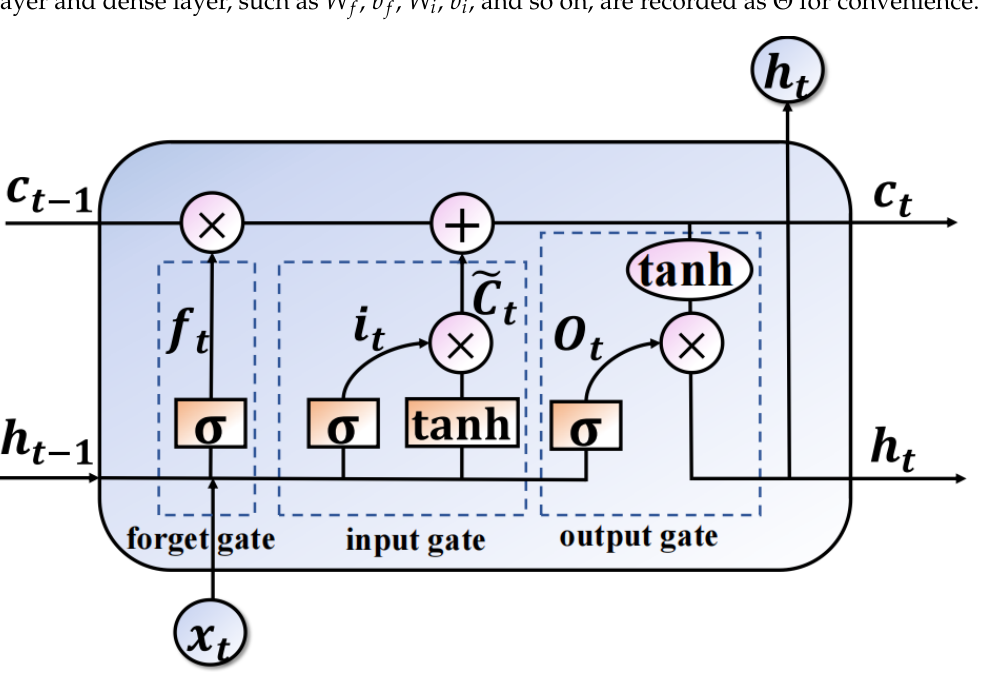
Figure 3. The structure of the LSTM network cell. The cell consists of three kinds of gates units called forget date, input gate, and output gate. f t is the output of the forget gate, i t is the output of the input gate, O t is the output of the output gate. x t is the input of the LSTM cell at time t , h t is the output of the LSTM cell. c t is the state of the LSTM at time t